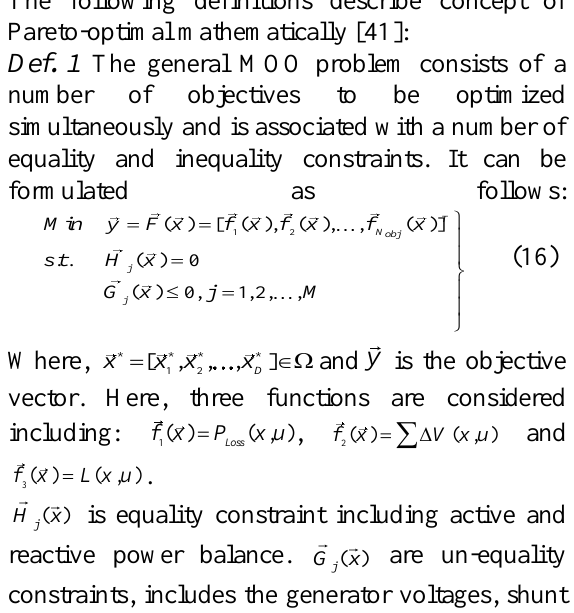
Figure 1. Depiction of domination using a two- objective minimization case